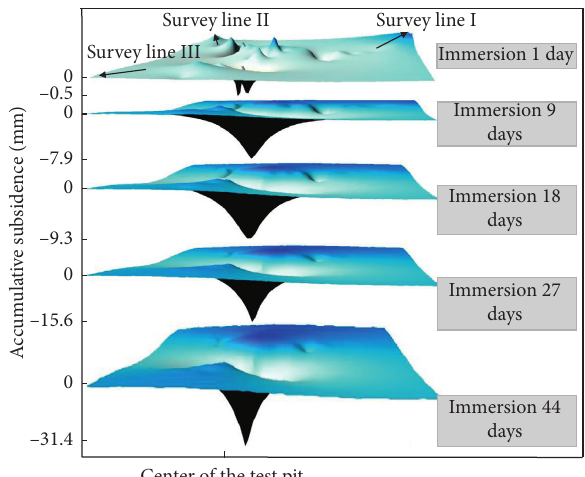
Figure 10: Accumulative surface subsidence curve of different immersion